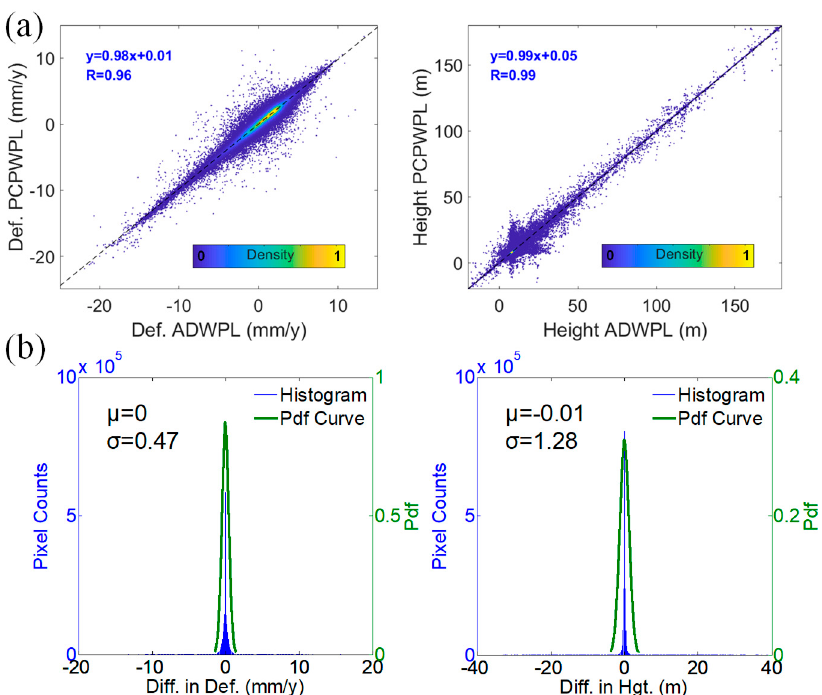
Figure 18. ( a ) Cross-validation using common pixels from ADWPL and PCPWPL, (left) deformation, (right) height; ( b ) histogram of the difference values between ADWPL and PCPWPL in (left) deformation and (right) height.